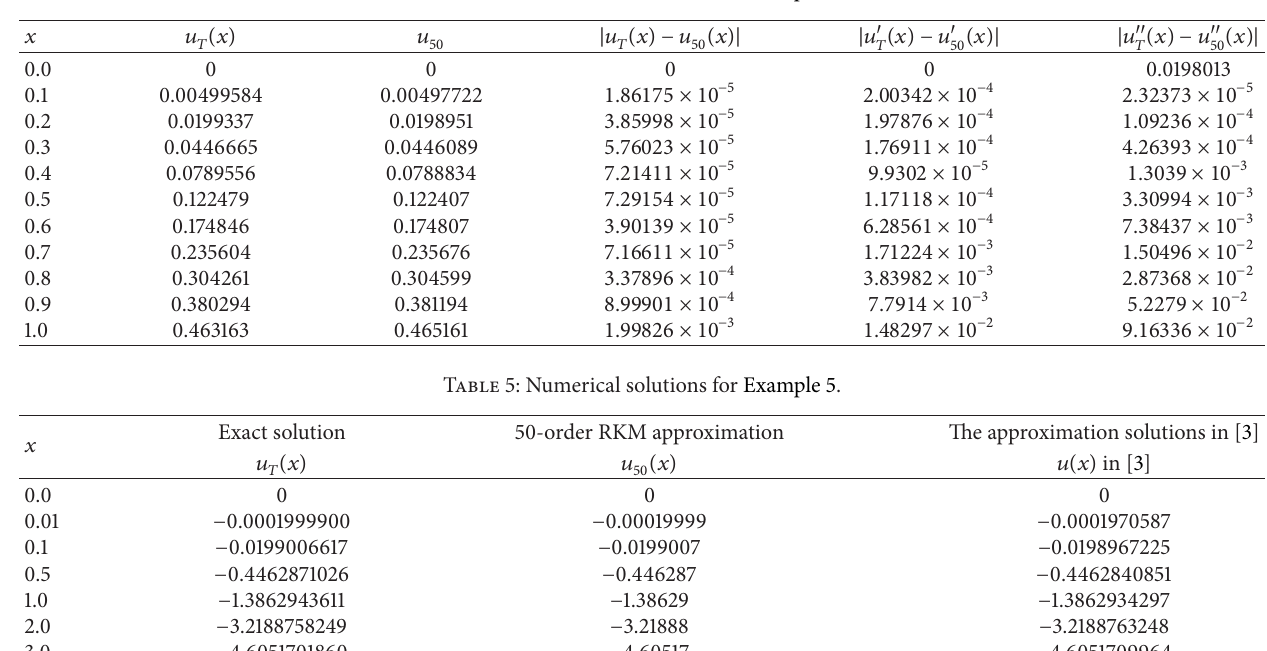
Table 4: Numerical solutions for Example 4.